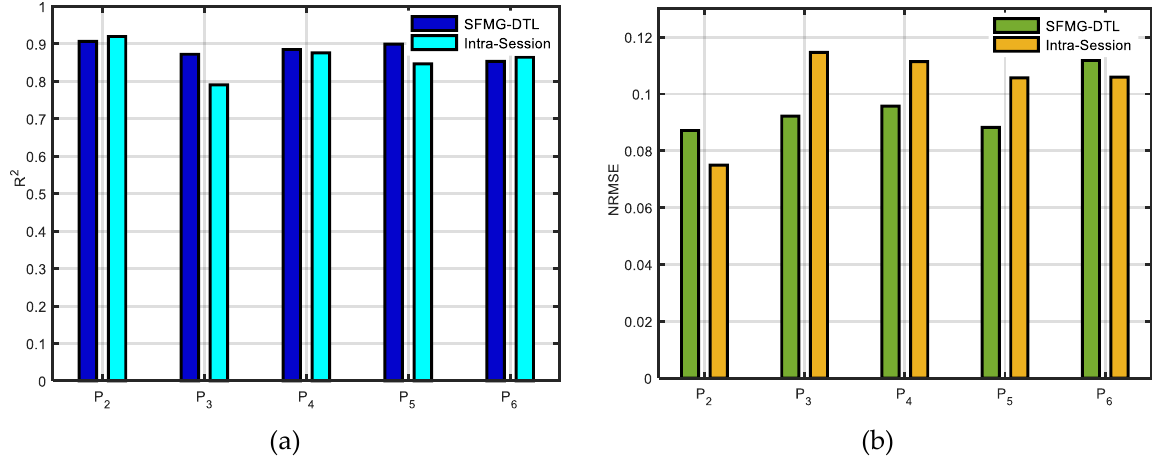
Figure 8. Performances of ML and DL models in case ii: on target dataset 2 (supervised domain generalization): ( a ) estimation accuracies (R 2 ) and ( b ) error in estimation (NRMSE). Averaged values (Model X and Model Y) are reported for both intra-session and SFMG-DTL.